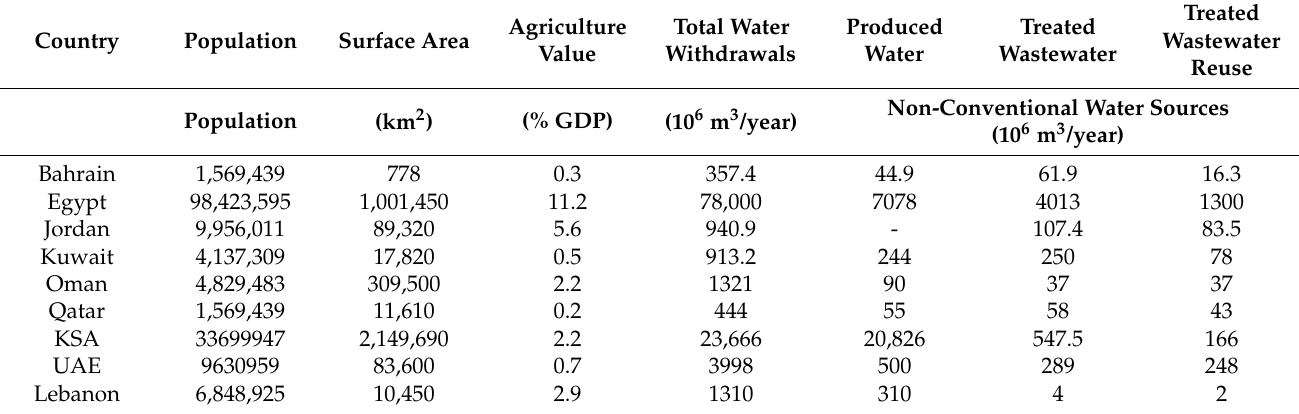
Table 1. Demography, agricultural contribution (%GDP), groundwater usage, and non-conventional water resources info from some of the representative Middle Eastern countries